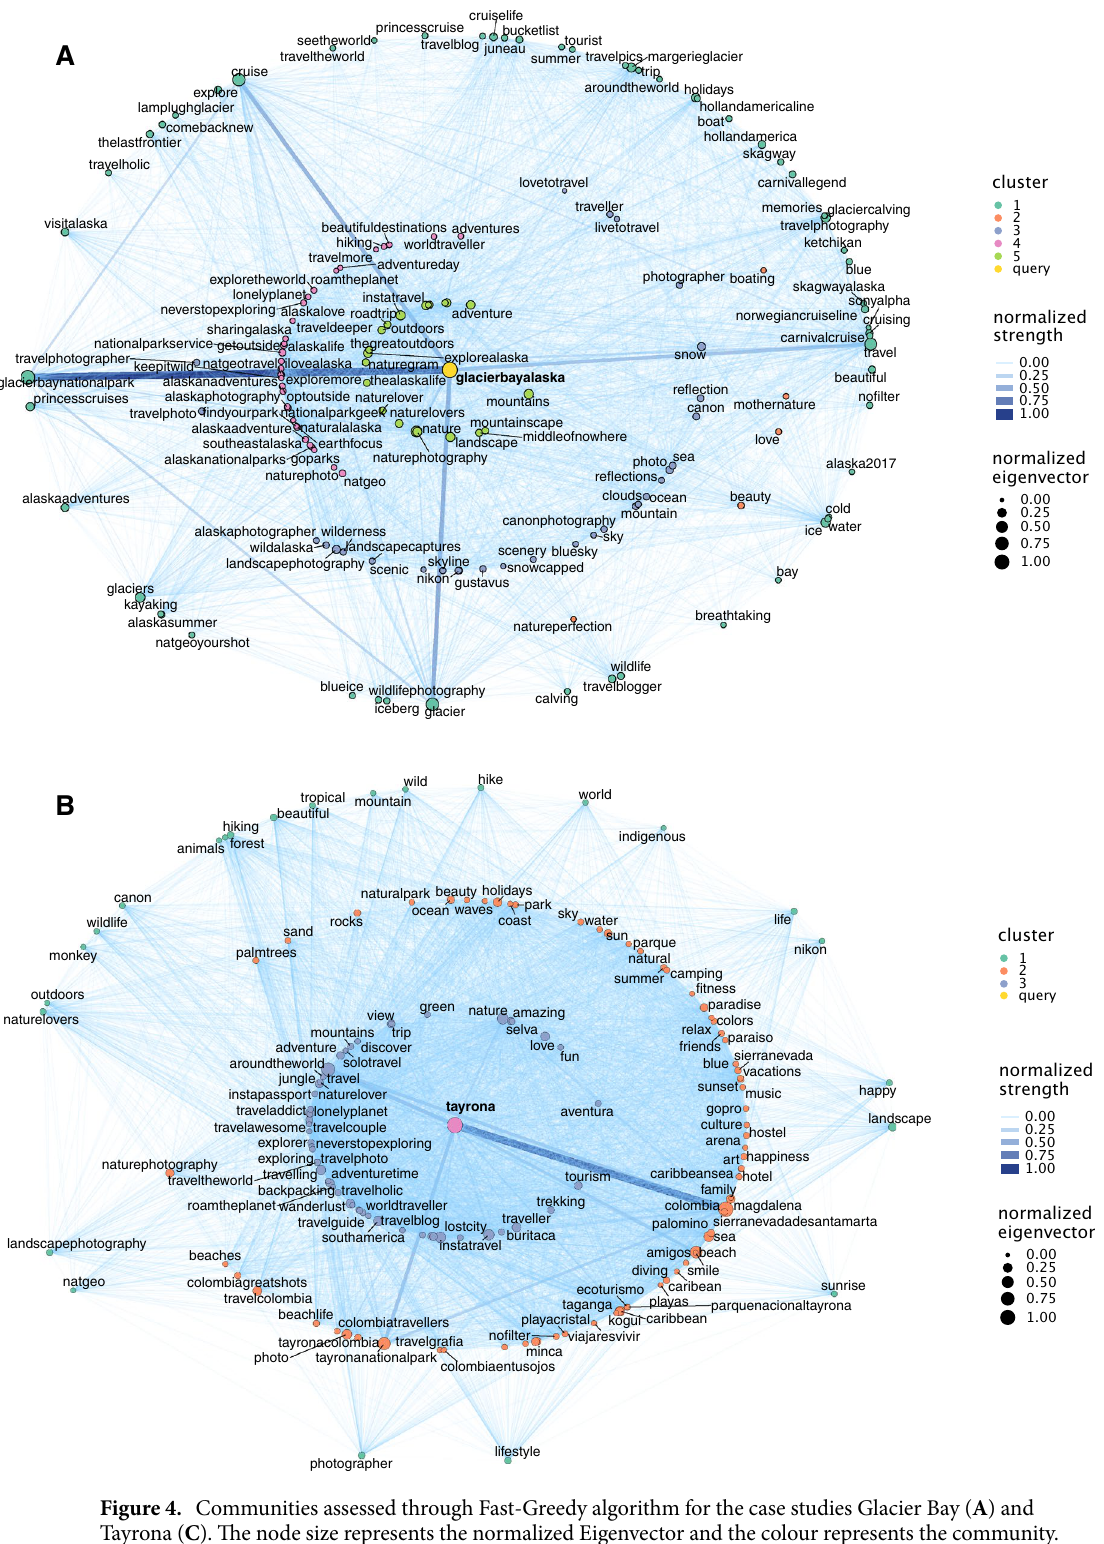
Figure 4. Communities assessed through Fast-Greedy algorithm for the case studies Glacier Bay ( A ) and Tayrona ( C ). The node size represents the normalized Eigenvector and the colour represents the community. The colour and width of the edges represents the normalized edge strength (weighted